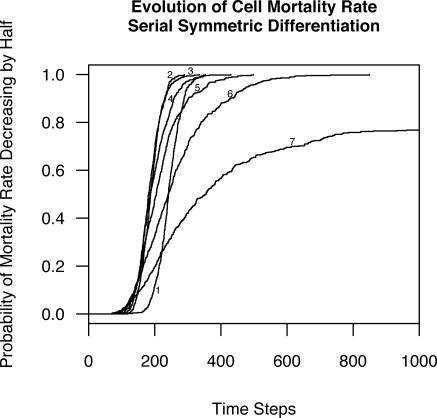
Kaplan-Meier Curves for the Probability that a Population of Cells Halves Its Average Mortality Rate as a Function of TimeEach curve is labeled with the number of differentiation stages in the model.